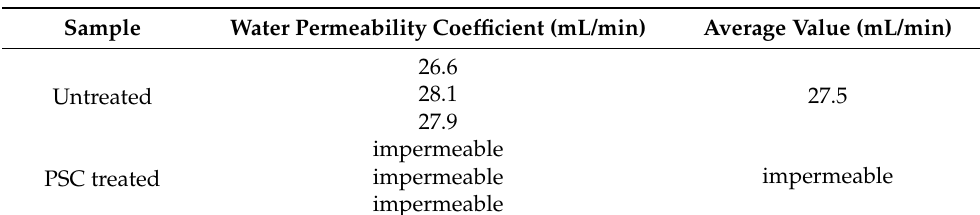
Table 4. Water permeability test results.